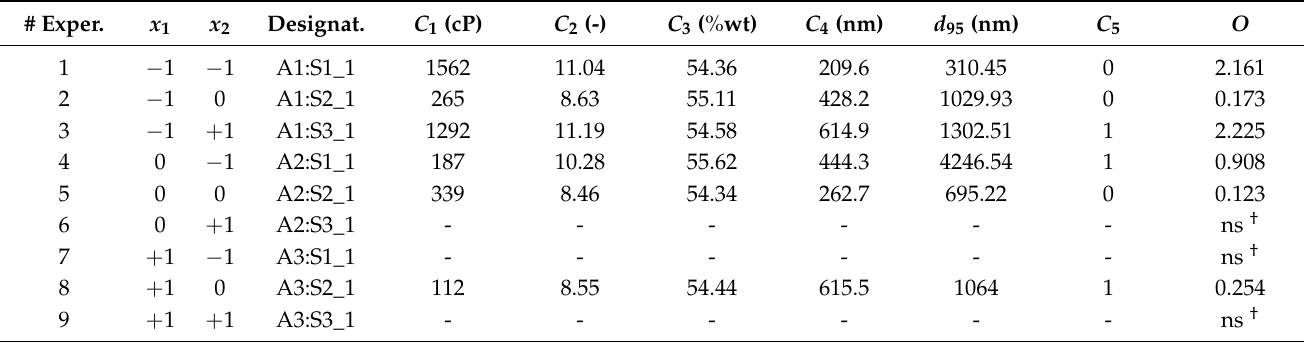
Table 5. Results of the experimental design in the screening of primary factors